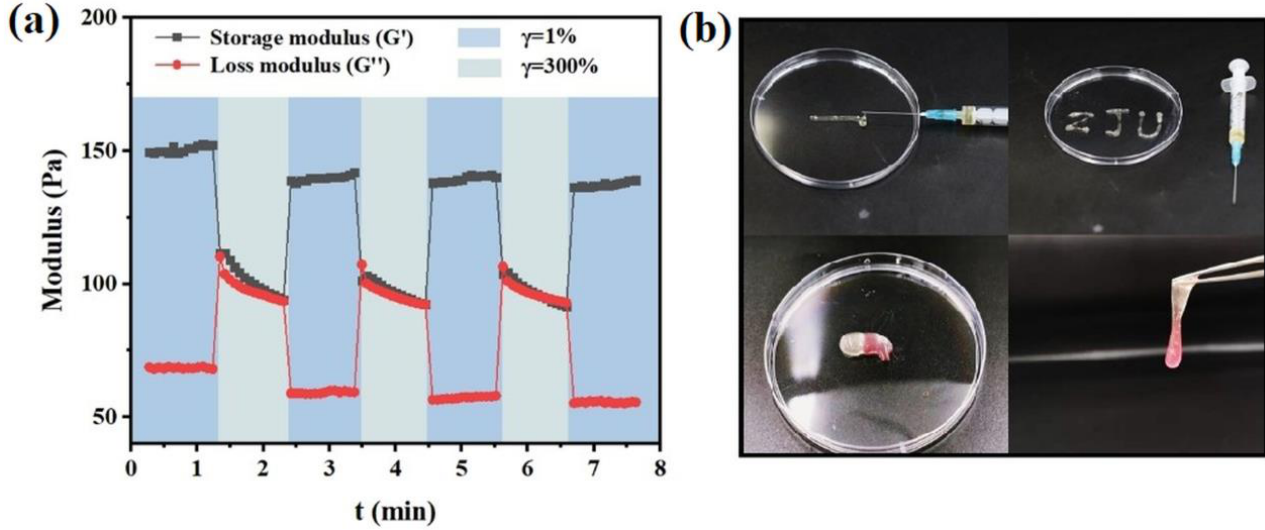
Figure 18. Illustration of ( a ) alternate-step strain test and (b) injection and self-healing phenomenon of the hydrogel based on 4-carboxy-3-fluorophenylboronic grafted chitooligosaccharides and guar gum (Adapted with permission from [112]. Copyright © 2023 Wiley-VCH GmbH).